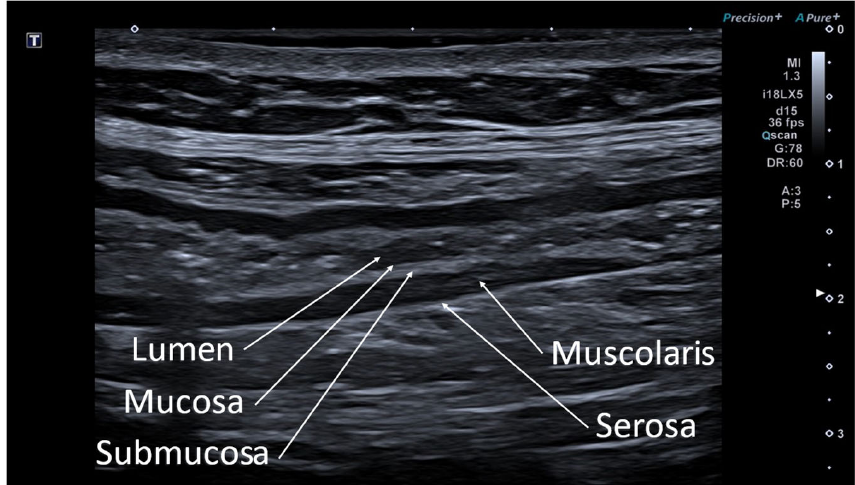
Figure 1. Image obtained with a high frequency linear probe. Longitudinal scan on the parietal stratification of bowel loop: the innermost portion represents the lumen, the first layer (hyperechoic) represents the interface between the mucosa and the lumen, the second layer (hypoechoic) to the mucosa, the third layer (hyperechoic) to the submucosa, the fourth layer (hypoechoic) to the muscolaris propria and fifth layer (hyperechic) to the interface echo between the muscolaris and the serosa.